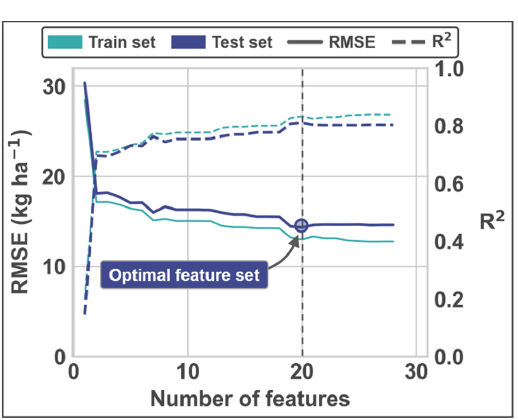
Figure A1. Influence of feature number on the root mean squared error (RMSE) and coefficient of determination (R 2 ) for the optimal image processing scenario. The RMSE and R 2 are illustrated for both the training and test sets for nitrogen uptake predicted by the lasso estimator. The optimal